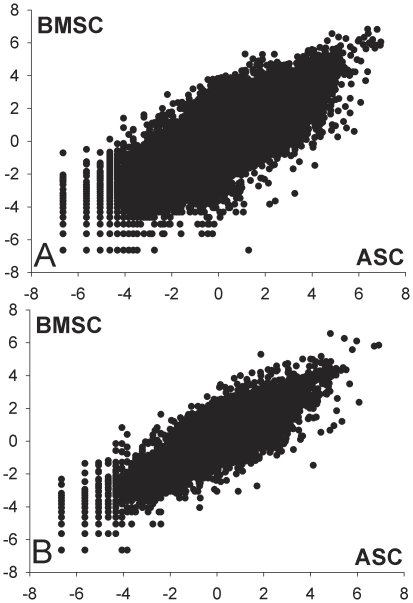
Overall correlation of the transcriptome between ASC and BMSC.Correlation of the transcriptome between ASC and BMSC during the whole experiment (top panel; r = 0.78; p<0.0001) or prior differentiation (bottom panel; r = 0.79; p<0.0001). This analysis highlights the large similarity between the two cell types both prior differentiation and during osteogenic or adipogenic differentiation.